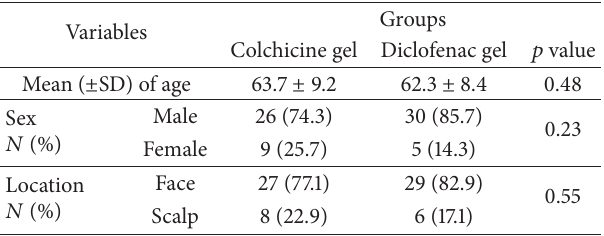
Table 1: Distribution of age and sex and location of the lesion in two groups separately.